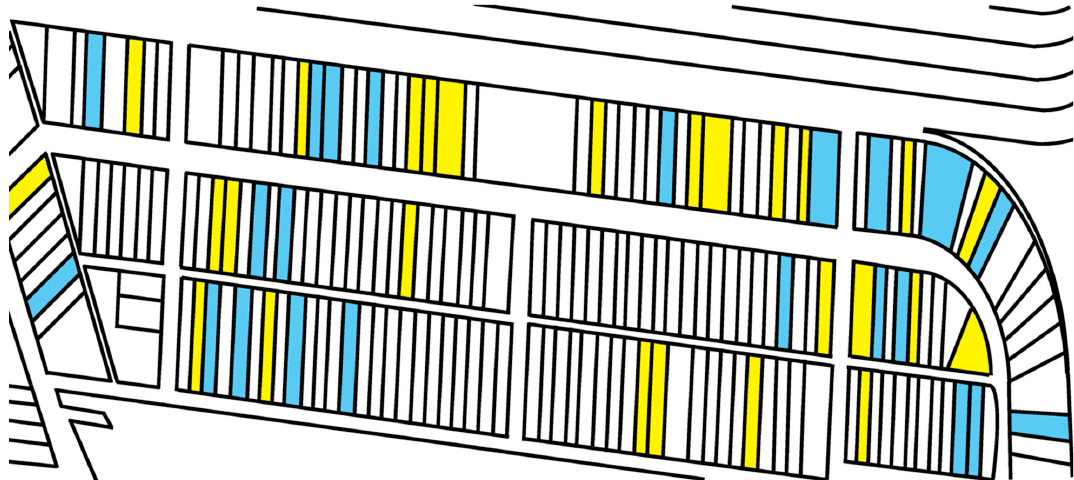
Figure 4. A random generator algorithm selected SE residences for soil sampling (blue residences). See the text for details.